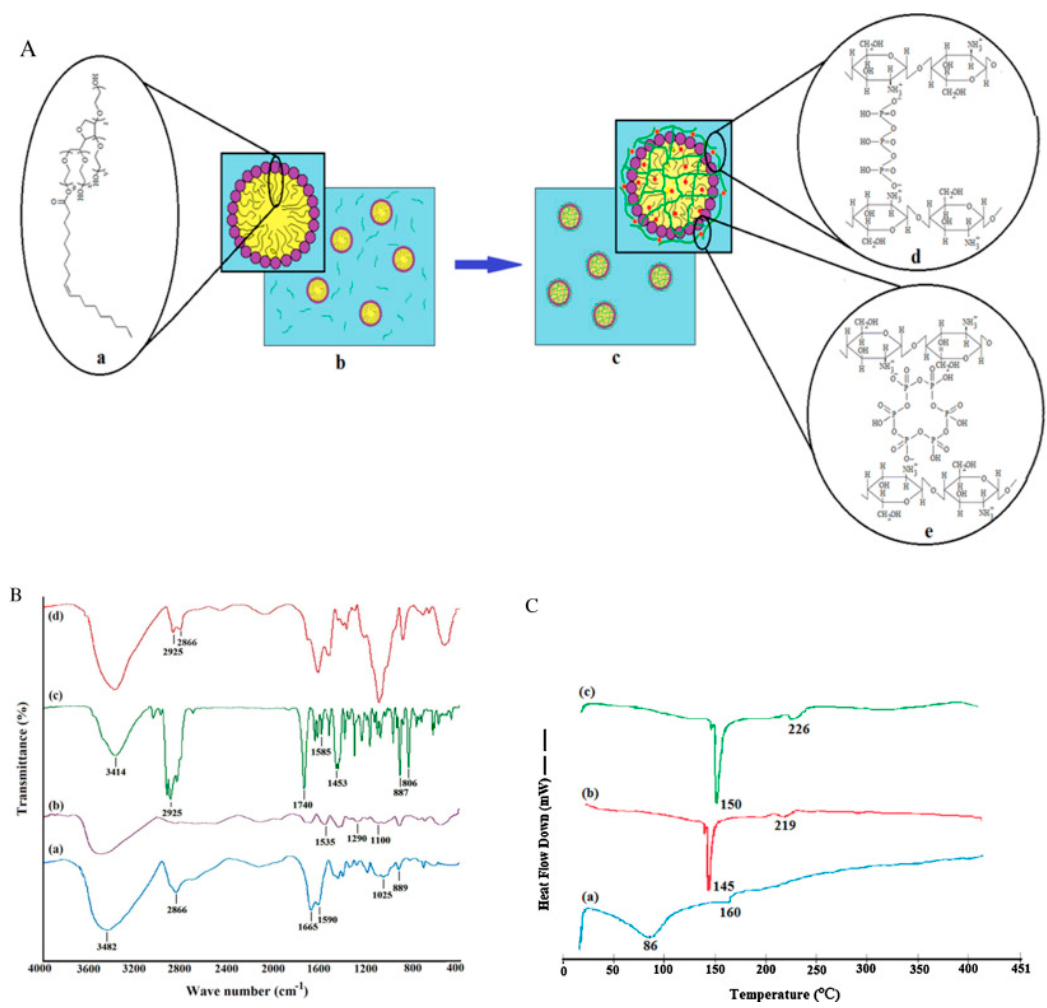
Figure 11. ( A ) Schematic representation of the chemical structure of Tween 80 (a), CEO in chitosan droplets ( oil-in-water emulsion) (b), CEO-loaded chitosan particles (c), the chemical structure of chitosan ionically cross-linked with TPP (d), and chemical structure of chitosan ionically cross-linked with HMP (e). ( B ) FTIR spectra of chitosan (a), chitosan–TPP nanoparticles (b), CEO (c), and CEO-loaded nanoparticles with a chitosan to CEO weight ratio of 1:0.25 (d). ( C ) DSC curves of CEO (a), chitosan–TPP nanoparticles (b), and CEO-loaded chitosan nanoparticles (c). Reproduced with permission from Esmaeili et al. [ 101 ]. Copyright 2015 Elsevier.